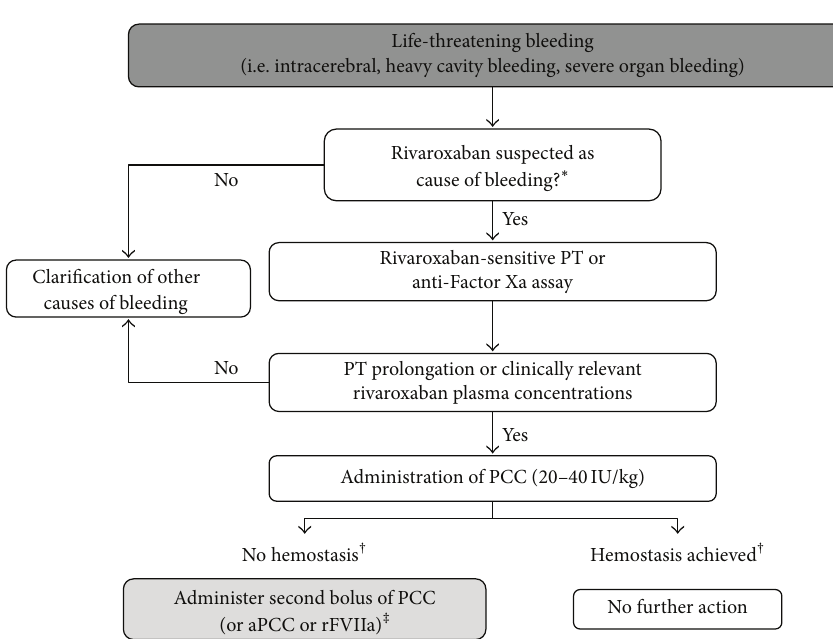
Figure 3: Special management of life-threatening bleeding in patients receiving rivaroxaban. ∗ Refers to information including timing of last dose of rivaroxaban, dose administered, and risk factors for bleeding (i.e., renal/hepatic function and concomitant medication). † After 10–15 minutes. ‡ Prothrombotic risk may be higher with aPCC or rFVIIa. aPCC = activated prothrombin complex concentrate; PCC = prothrombin complex concentrate; PT = prothrombin time; rFVIIa = recombinant activated Factor